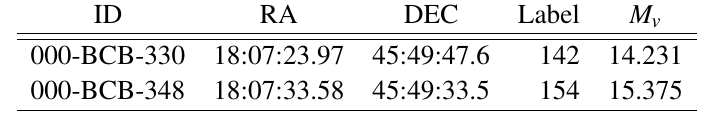
Table 3 List of the comparison and the check of DQ Her.